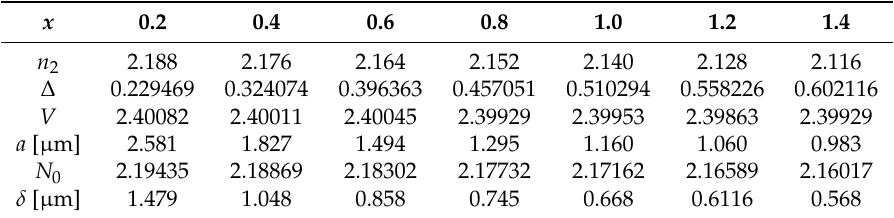
Table 2. Effect of diamagnetic substitution, x , in yttrium iron garnet Y 3 Fe 5 parameters: the cladding index of refraction, n 2 , ∆